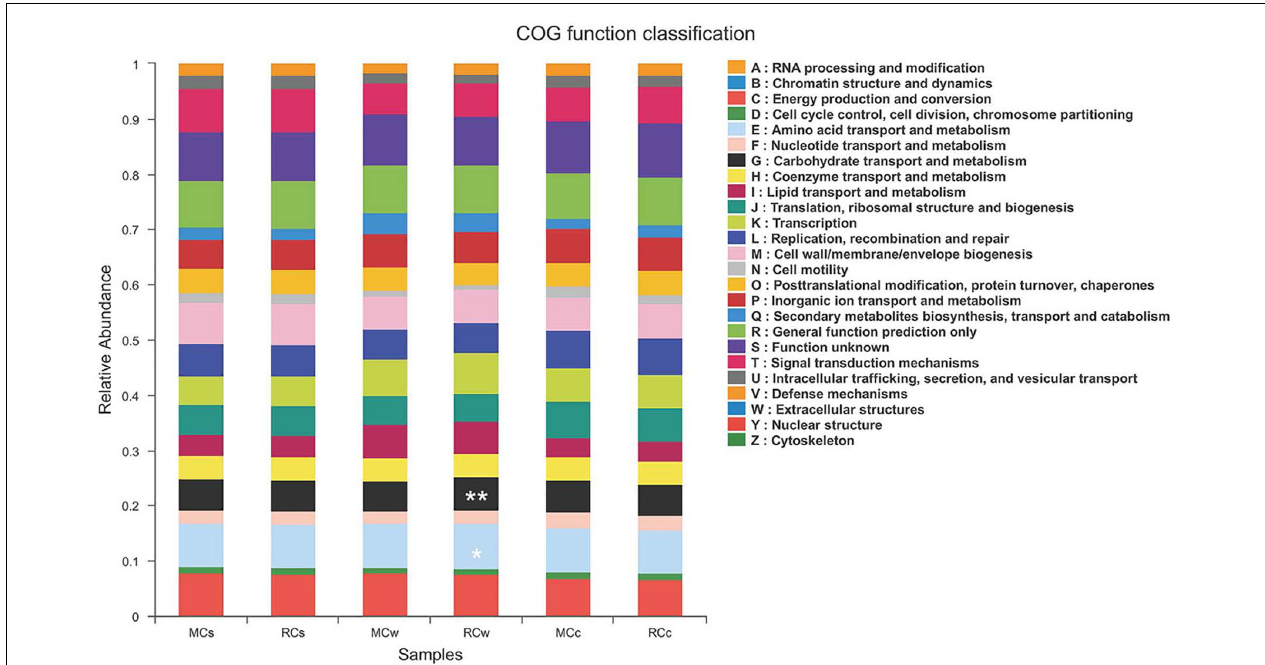
FIGURE 7 | Clusters of orthologous group (COG) function classification of the six sampling groups. * indicate COG functions significant difference between MCw and RCw. * 0.01 < P ≤ 0.05; ** 0.001 < P ≤ 0.01.